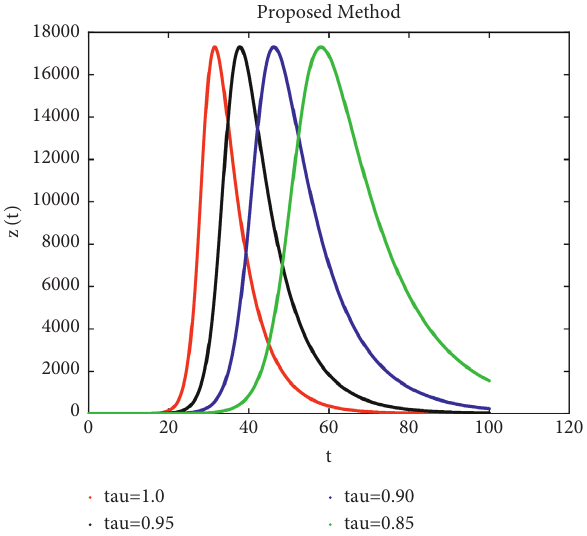
Figure 11: Dynamical behavior of concentration of uninfected (susceptible) cells at τ � 1 and various fractional order under Mittag-Leffler kernel.